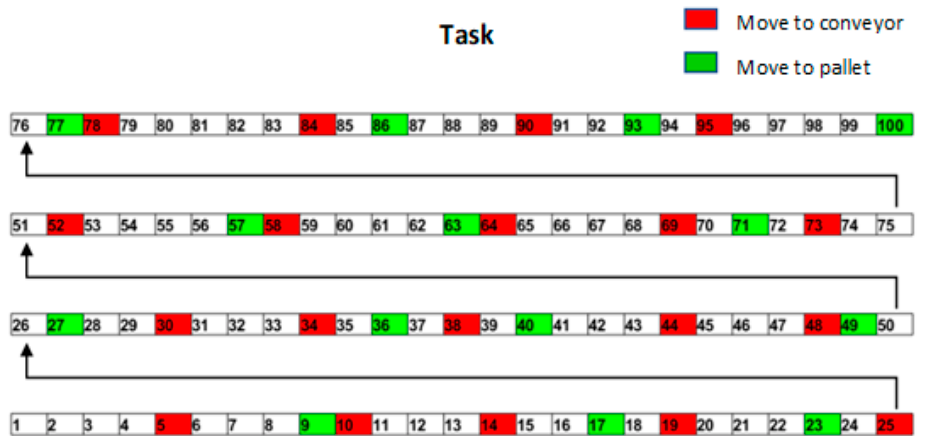
Figure 10. The optimized workflow of the best individual obtained from the algorithm.